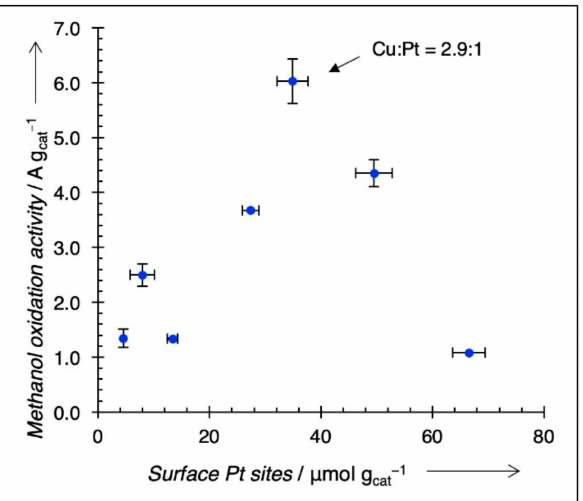
Figure 8. MeOH electrooxidation activity vs. a number of Pt surface sites (Pt s ). If increased activity is simply because there are more Pt surface sites, there should be an upward linear trend. However, this is not the case, and maximum activity is maintained at Cu 3 Pt 1